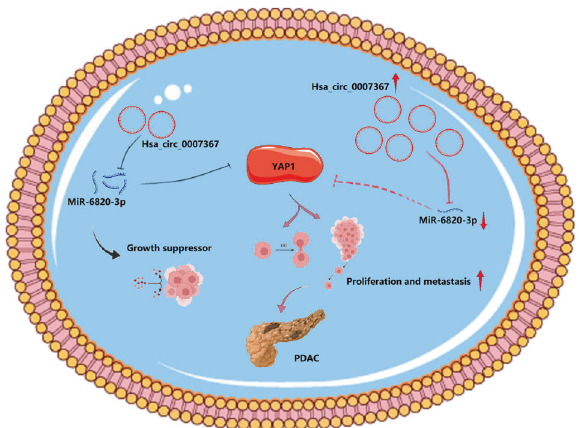
Fig. 9 Hsa_circ_0007367/miR-6820-3p/YAP1 axis promoted the progression of PDAC. Hsa_circ_0007367 upregulated YAP1 expres- sion via sponging miR-6820-3p to facilitate the proliferation, migration and invasion of PDAC